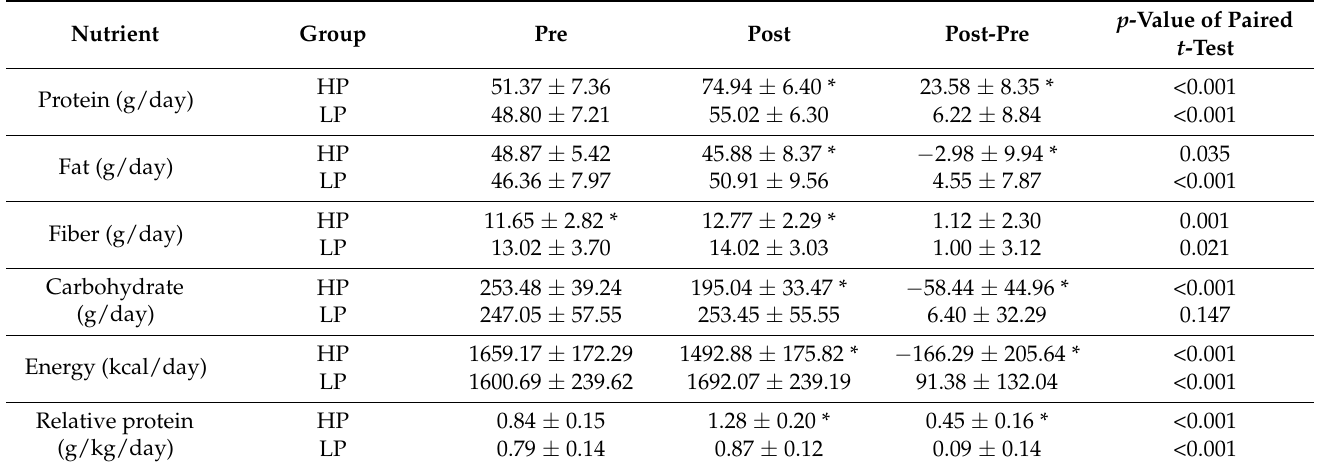
Table 3. Energy and macronutrients (mean ±